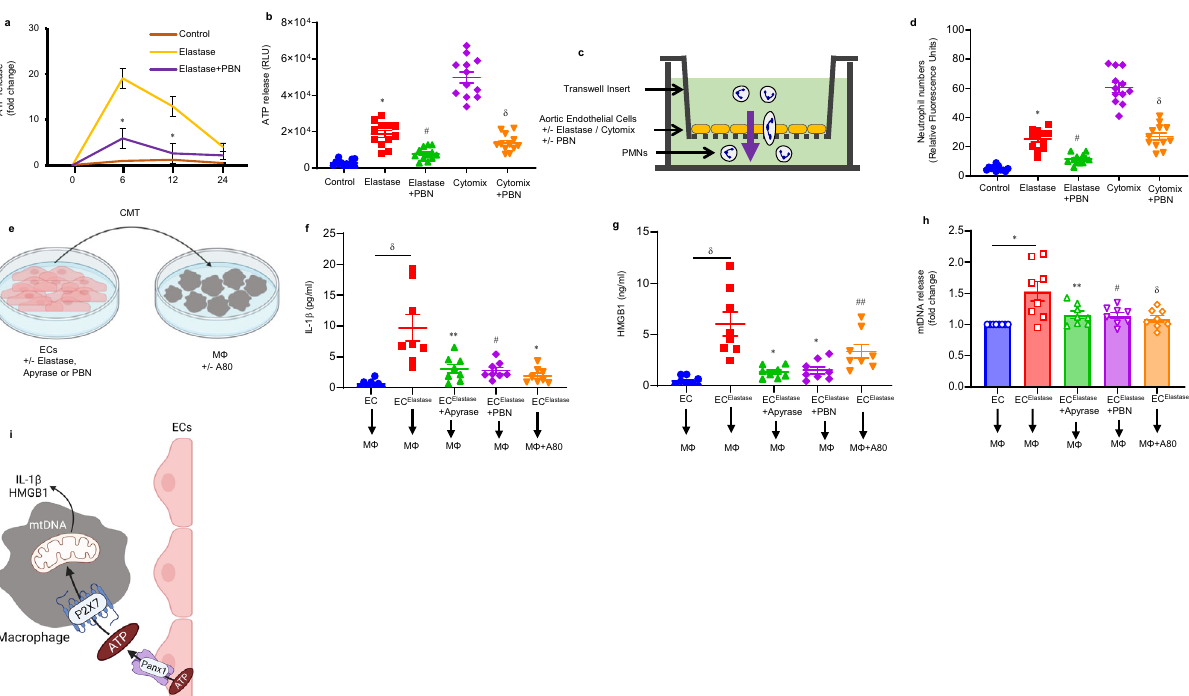
Fig. 5 Panx1-dependent ATP release from ECs modulates neutrophil transmigration and macrophage activation. a Transient elastase-treatment- induced eATP release from EC cultures is signi fi cantly mitigated by PBN treatment at 6- and 12 h. * P < 0.0001 vs. elastase; n = 12/group. b Elastase- and/ or cytomix-induced eATP release by ECs is attenuated by Panx1 inhibition via PBN treatment compared with untreated controls. * P < 0.0001 vs. control; # P = 0.0009 vs. elastase; δ P < 0.0001 vs. cytomix; n = 12/group. c Schematic showing the in vitro transwell model to demonstrate transendothelial migration of polymorphonuclear neutrophils (PMNs). Fluorescent-labeled primary murine-derived PMNs were included in the top chamber containing ECs and cocultured for 24 h. d Exposure to elastase or cytomix showed a signi fi cant increase in neutrophil transmigration, which was signi fi cantly attenuated by pretreatment with PBN. * P < 0.0001 vs. control; # P = 0.0002 vs. elastase; δ P < 0.0001 vs. cytomix; n = 12/group. e Schematic depicting conditioned media transfer (CMT)-based experiments from elastase-treated ECs to macrophages with/without pretreatment with inhibitors. f , g CMT from elastase-treated ECs to macrophages induces a signi fi cant upregulation of IL-1 β and HMGB1 secretion, which was blocked by pretreatment of ECs with apyrase or PBN, as well as pretreatment of macrophages with P2X7 inhibitor (A80). δ P < 0.0001 vs. EC → M Ф ; * P = 0.0001, ** P = 0.0009, # P = 0.0005 and ## P = 0.03 vs. EC elastase → M Ф ; n = 8/group. All comparative data above are represented as mean values± SEM and statistical analyses were done by one-way ANOVA. h Panx1-dependent ATP release from ECs stimulates mtDNA release that is prevented by PBN and P2X7R inhibition. CMT from elastase-induced ECs was performed on macrophages. DNA was isolated from cytosolic fractions of macrophages and the levels of mitochondrial (mt)DNA were analyzed by quantitative RT-PCR. CMT from elastase-treated ECs to macrophages induces a signi fi cant upregulation of mtDNA release, which was blocked by pretreatment of ECs with apyrase or PBN, as well as pretreatment of macrophages with P2X7 inhibitor. * P = 0.0005; ** P = 0.02, # P = 0.01, and δ P = 0.004 vs. EC elastase → M Ф ; n = 8/group. Data are presented as fold change relative to EC → M Ф and compared using two-tailed Wilcoxon test. i Schematic displaying the crosstalk between ECs and macrophages via Panx1-dependent release from elastase-induced ECs that stimulates P2X7R and mtDNA release from